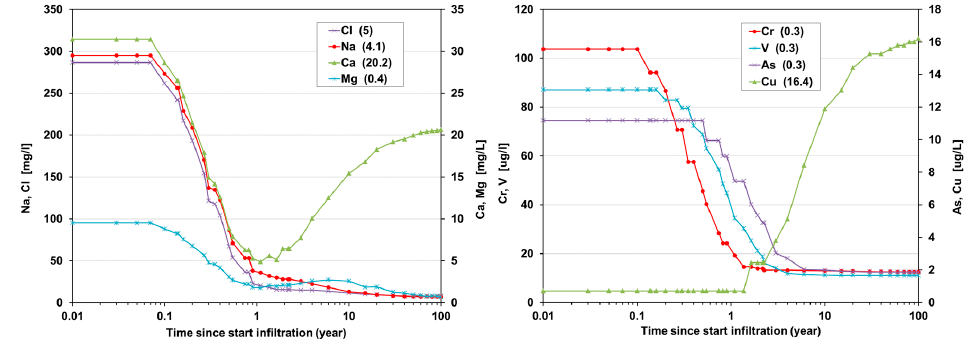
Figure 11. With EL calculated concentration trends of selected main constituents and trace elements in groundwater that flowed past all recovery wells during nonstop infiltration via a recharge basin.